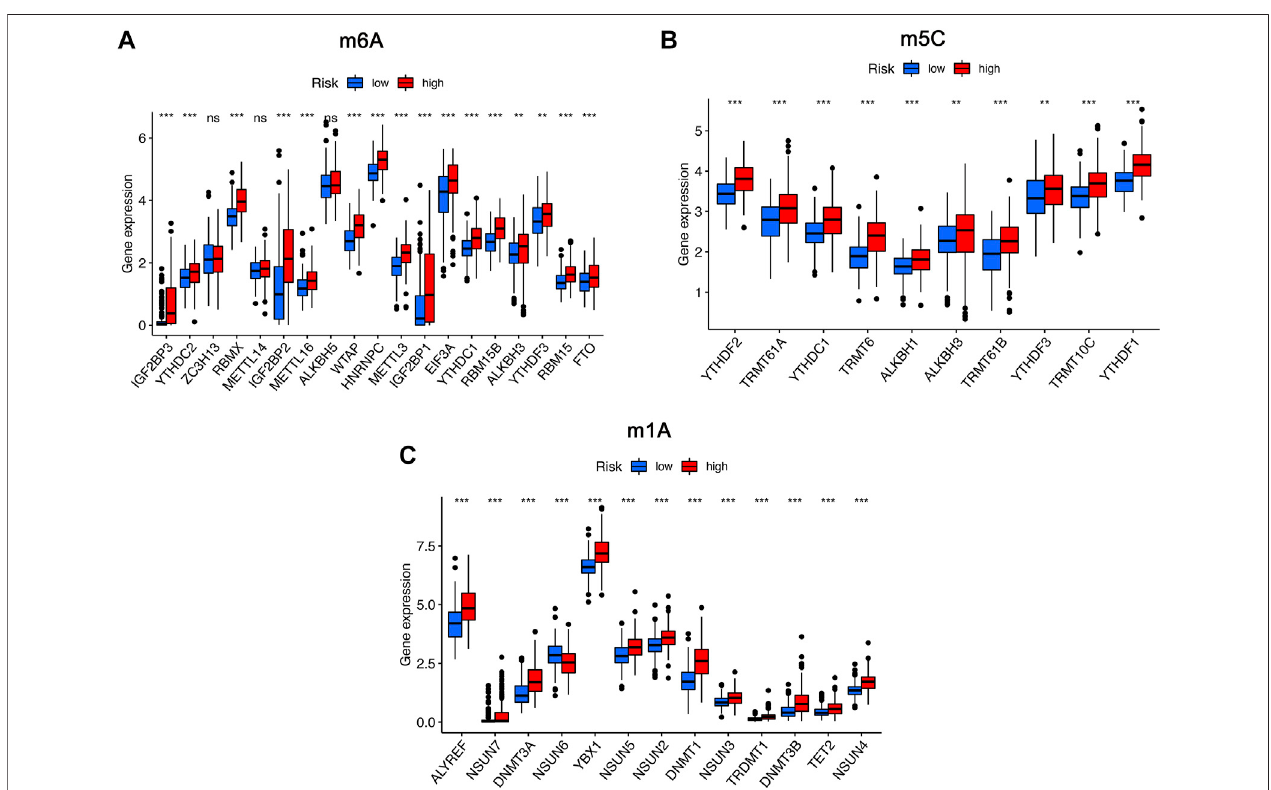
FIGURE8| TheexpressionofRNAmodi fi cation-relatedgenesbetweenthehigh-andlow-riskgroups. (A) Theexpressionofm6A-relatedgenesbetweenthehigh- and low-riskgroups. (B) Theexpression ofm5C-relatedgenesbetweenthehigh- andlow-riskgroups. (C) Theexpression ofm1A-related genesbetweenthehigh-and low-risk groups. ns, not signi fi cant; * p < 0.05; ** p < 0.01; *** p < 0.001.